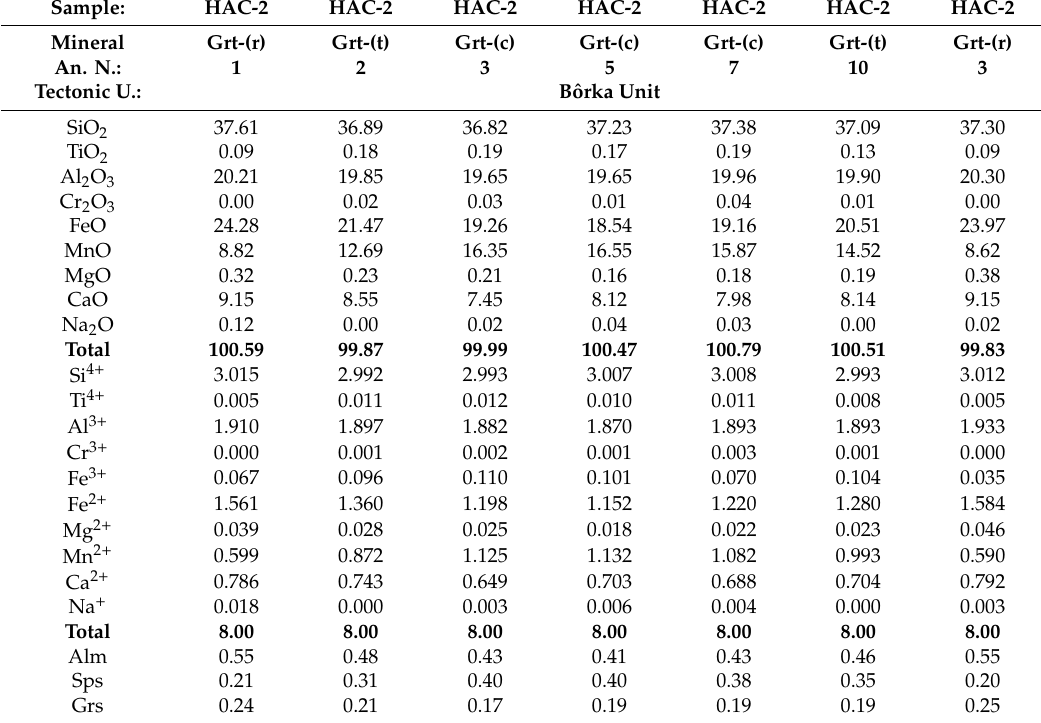
Figure 15. BSE images from the Haˇcava metabasalts of the B ô rka Unit: ( A , B ) the Gln–Ph–Grt assemblage of the peak (D1) metamorphic stage seen in blueschist at Haˇcava village. Table 2. Representative analyses of the garnet from the B ô rka